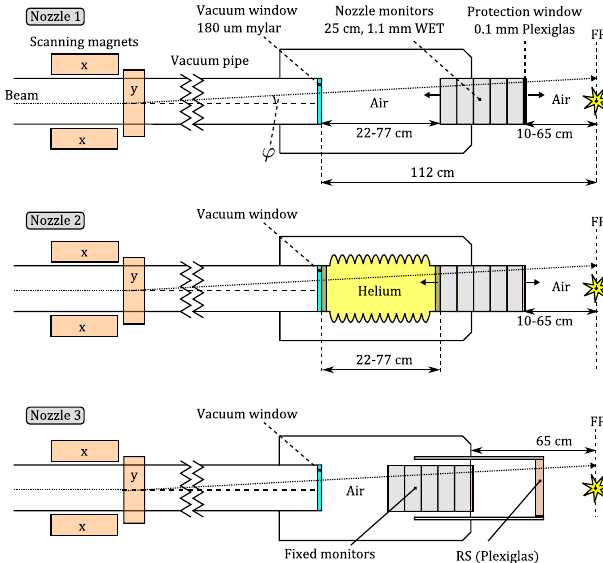
FIG. 5. Different nozzle options: 1 movable monitors; 2 movable monitors and helium chamber after vacuum window; 3 fixed monitors, movable (and removable) range